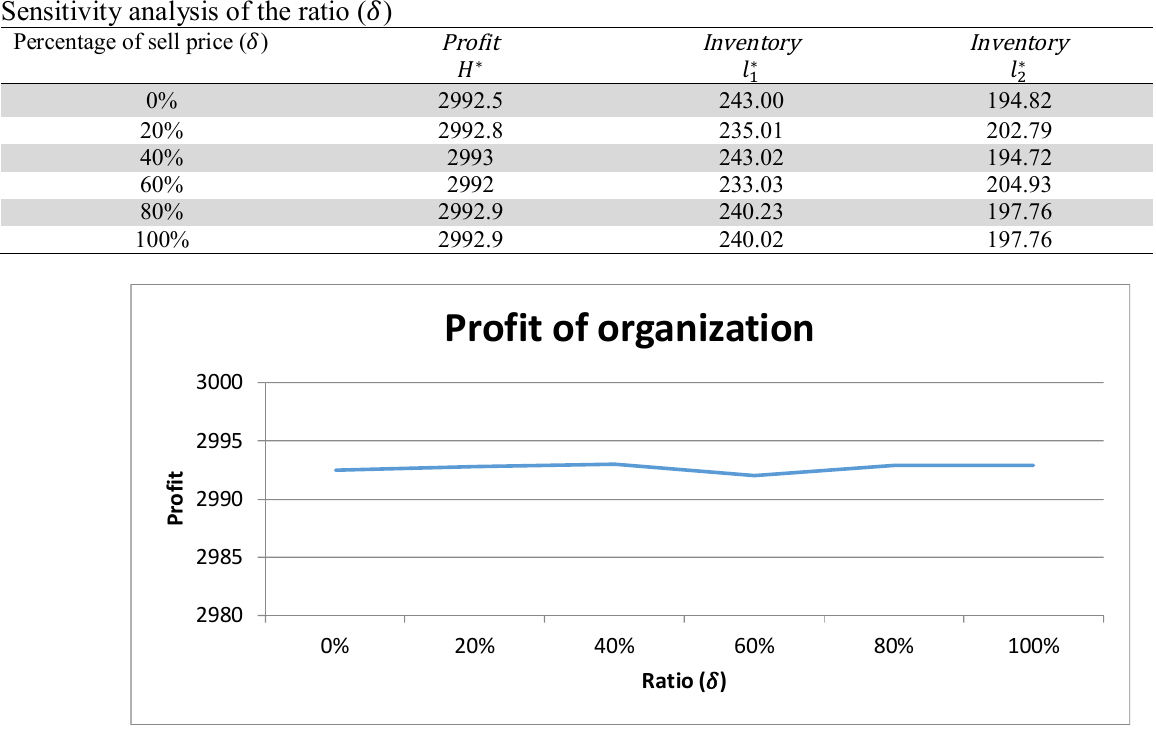
Fig. 7. Chart of the ratio ( (cid:2012)